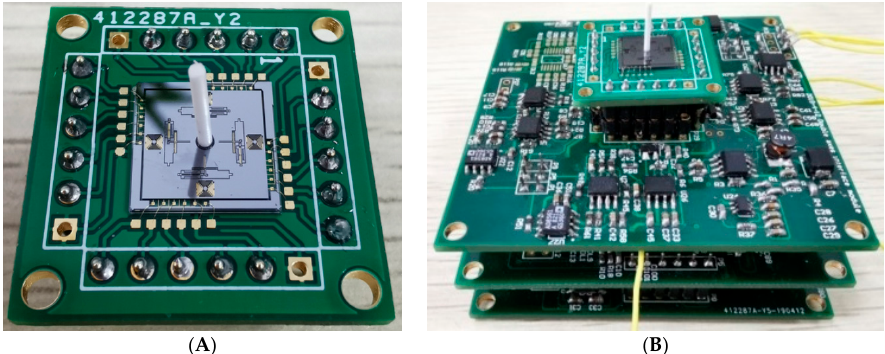
Figure 11. Peripheral hardware. ( A ) Interface board. ( B ) Fabricated control and measurement circuits.